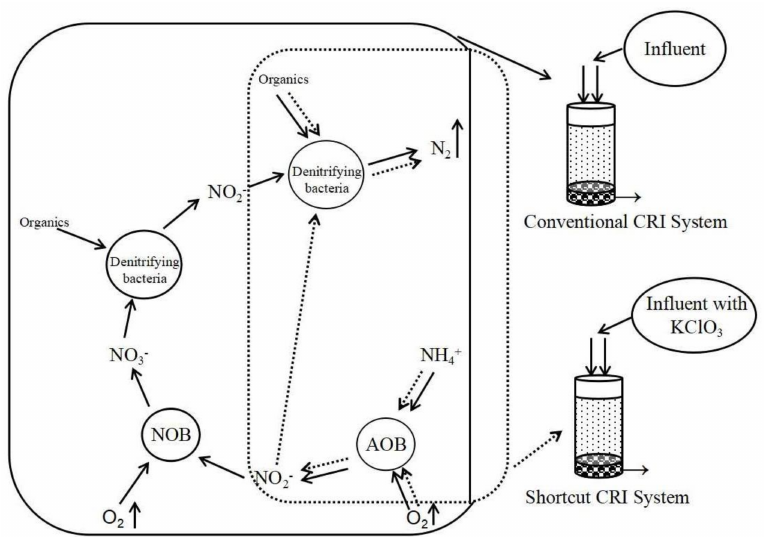
Figure 2. Comparison of the full nitrification–denitrification process and shortcut nitrification–denitrification process ( → represents the process of full nitrification–denitrification; (cid:57)(cid:57)(cid:75) represents the process of shortcut